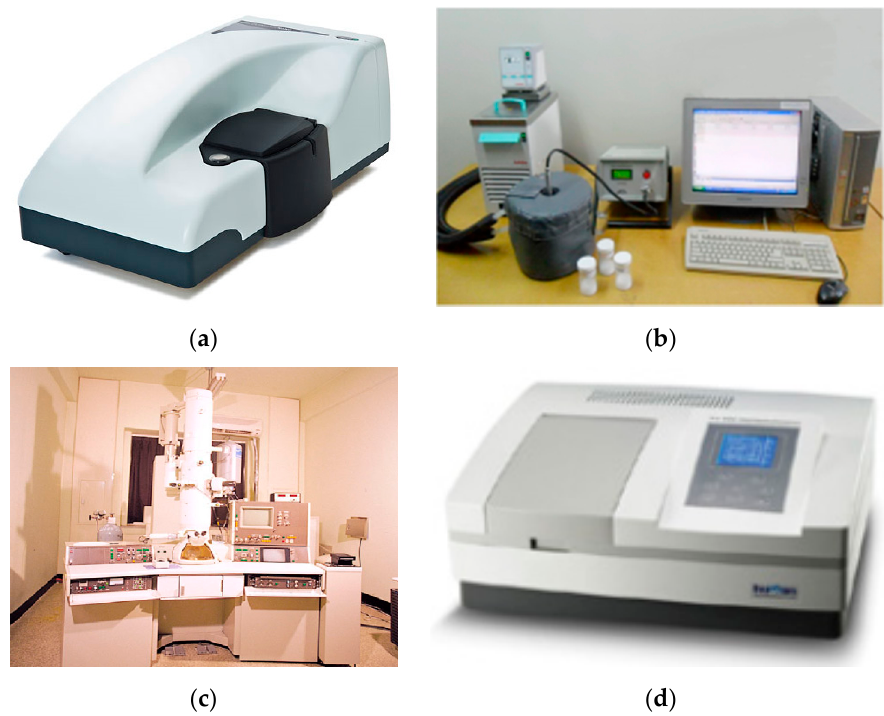
Figure 2. Photograph of measurement equipments. ( a ) Zetasizer, Nano590; ( b ) Thermal Conductivity measuring system LAMBDA; ( c ) Transmission Electron Microscopy; ( c ) X ‐ ma 3100.